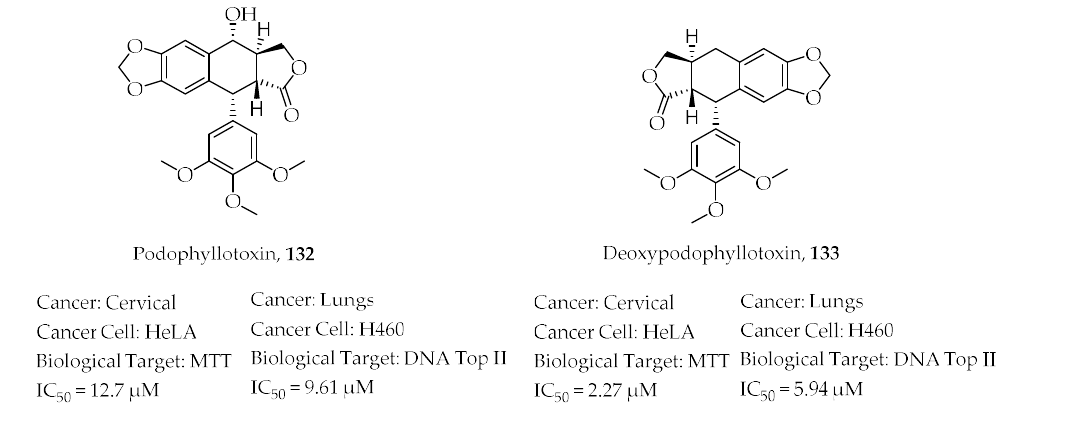
Figure 26. Structure of the cyclolignans Podophyllotoxin and Deoxpodophyllotoxin with a summary of their biological activity towards selected cancer targets.